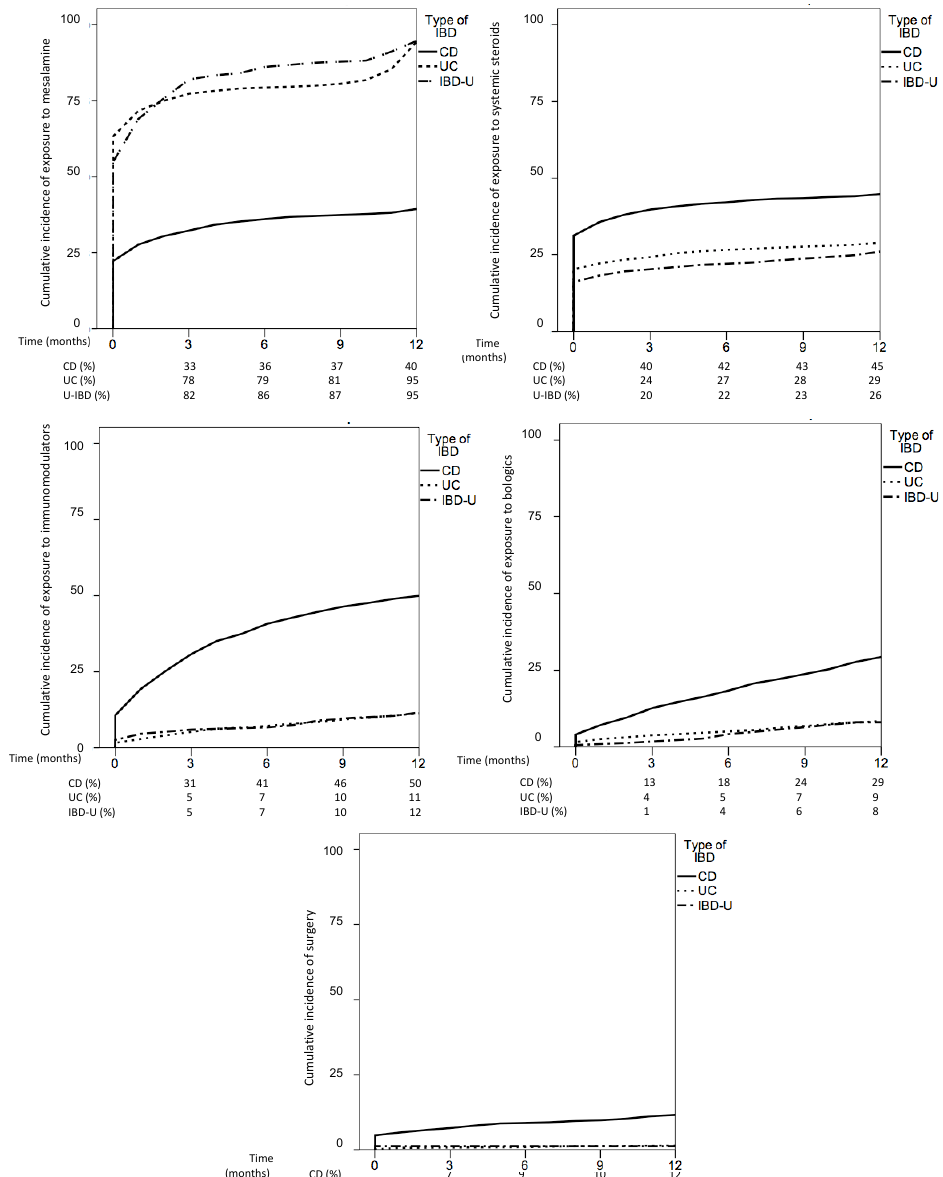
Figure 2. Cumulative incidence of exposure to treatments in Crohn’s disease (CD), ulcerative colitis (UC) and inflammatory bowel disease unclassified (IBD-U) during follow-up.